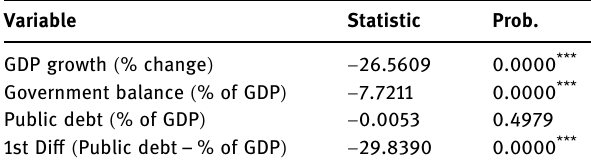
Table 7: Stationarity test results